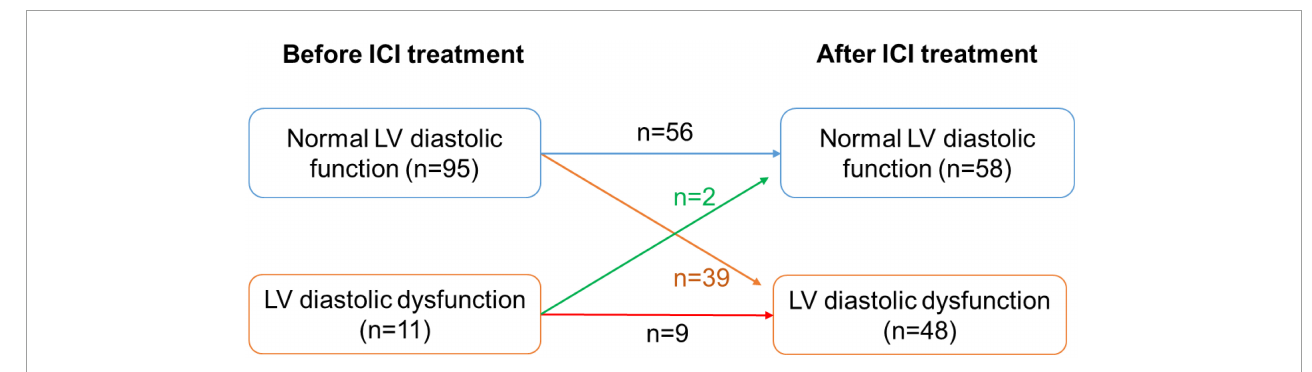
FIGURE7 Number of patients with LV diastolic dysfunction before and after ICI treatment. LV, left